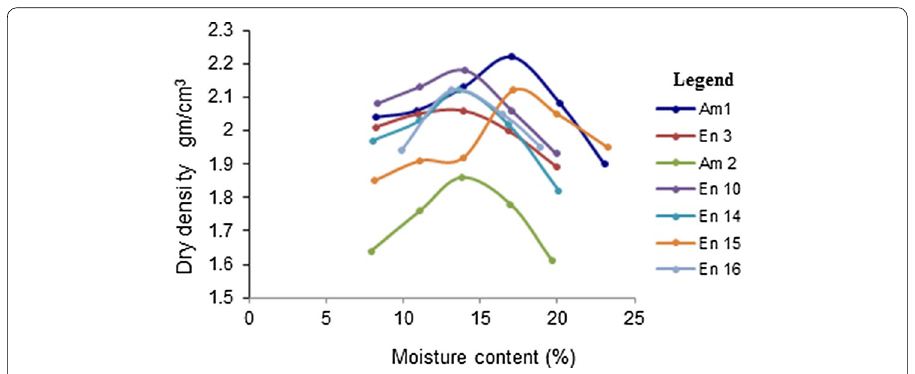
Fig. 8 Compaction curves of the samples